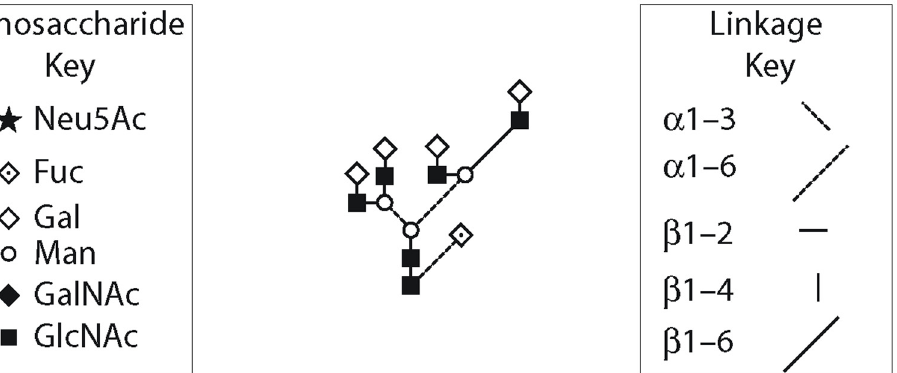
Fig 3. Schematic diagram for the tetra-antennary glycan used in the simulations. The α / β 1 – 6 linkage line is longer, which indicates the carbon atom is exocyclic. All other linkages involve ring carbons.